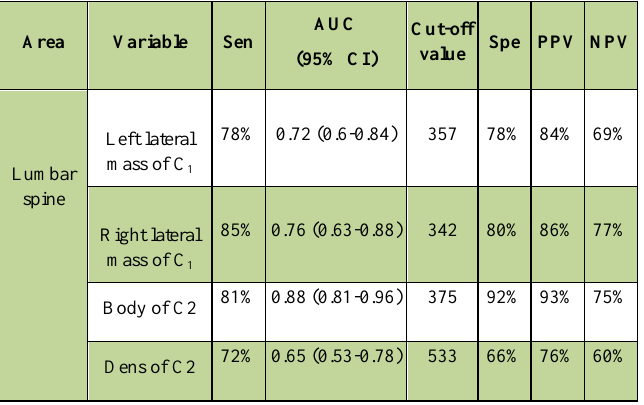
Table 3: Validity of the values of RD in the prediction of osteopenia